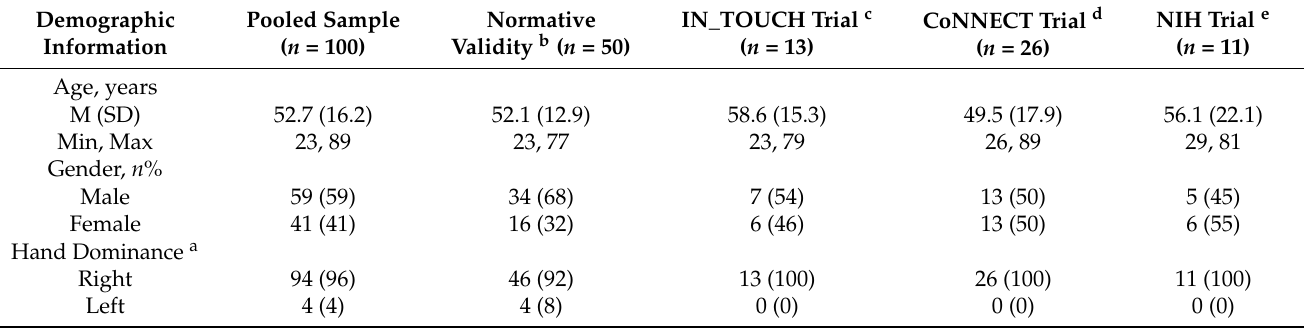
Table 2. Demographic characteristics of neurologically healthy participants from pooled and individ- ual study